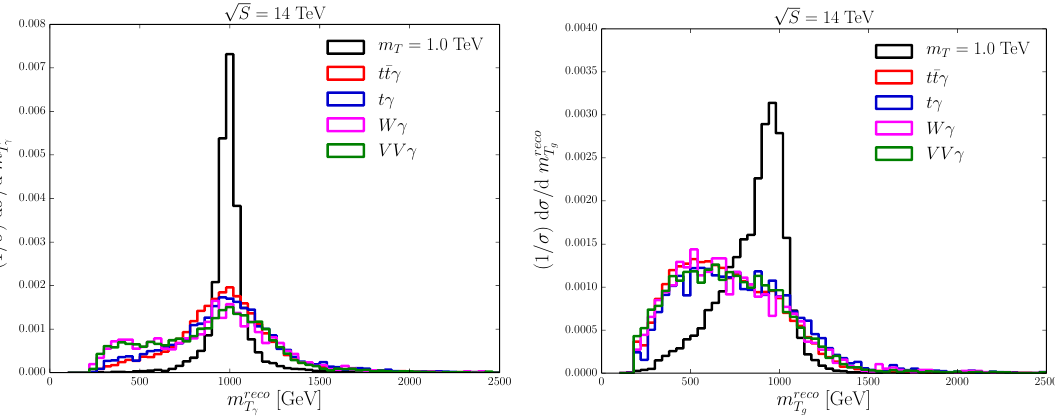
Figure 7 . The distributions of reconstructed top partner invariant masses m reco (right) in the ttg(cid:13) channel for m T = 1 : 0 TeV.